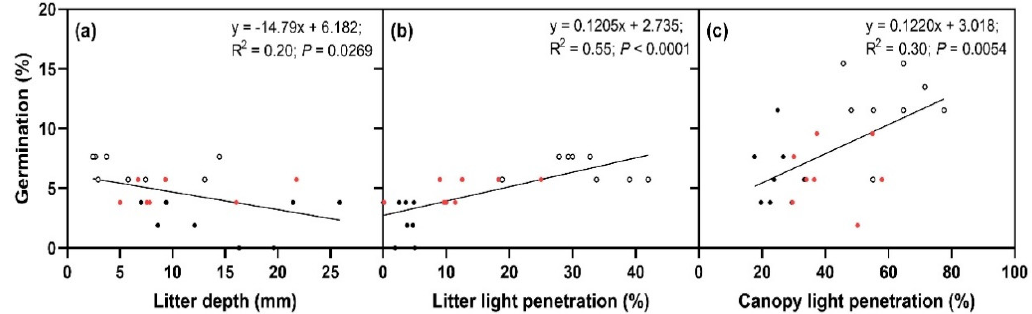
Figure 5. Correlation of Eucalyptus benthamii seed germination with litter depth ( a ) litter light penetration ( b ) and canopy light penetration ( c ) after zero, two, and four years after prescribed fire. White, red, and black dots are 0, 2 and 4 years since burn, respectively. When exploring relationships between percent germination and litter depth ( a ) or litter light penetration ( b ), only data from unraked sub-plots were used. Similarly, when exploring relationships between percent germination and canopy light penetration ( c ), only data from raked sub-plots were